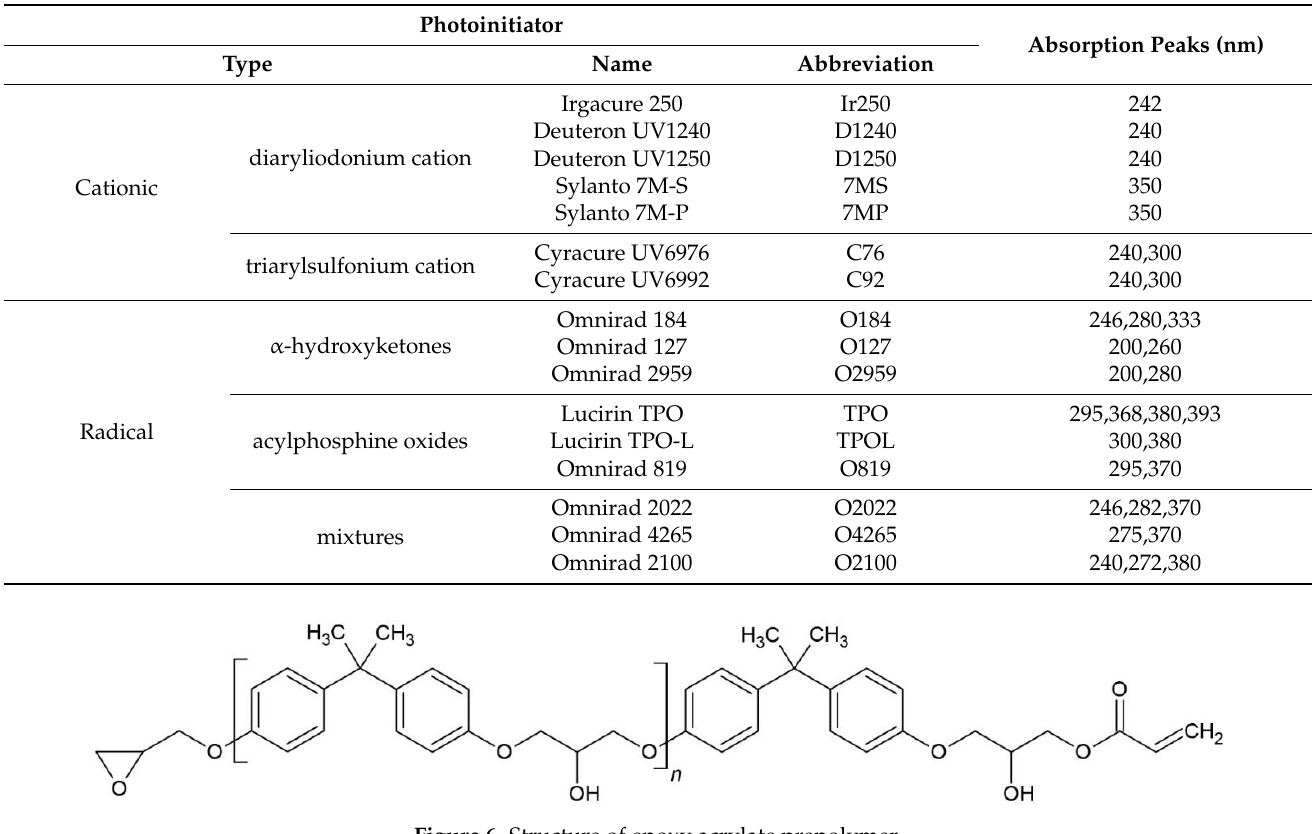
Table 1. The maximum absorption peaks of the photoinitiators used.